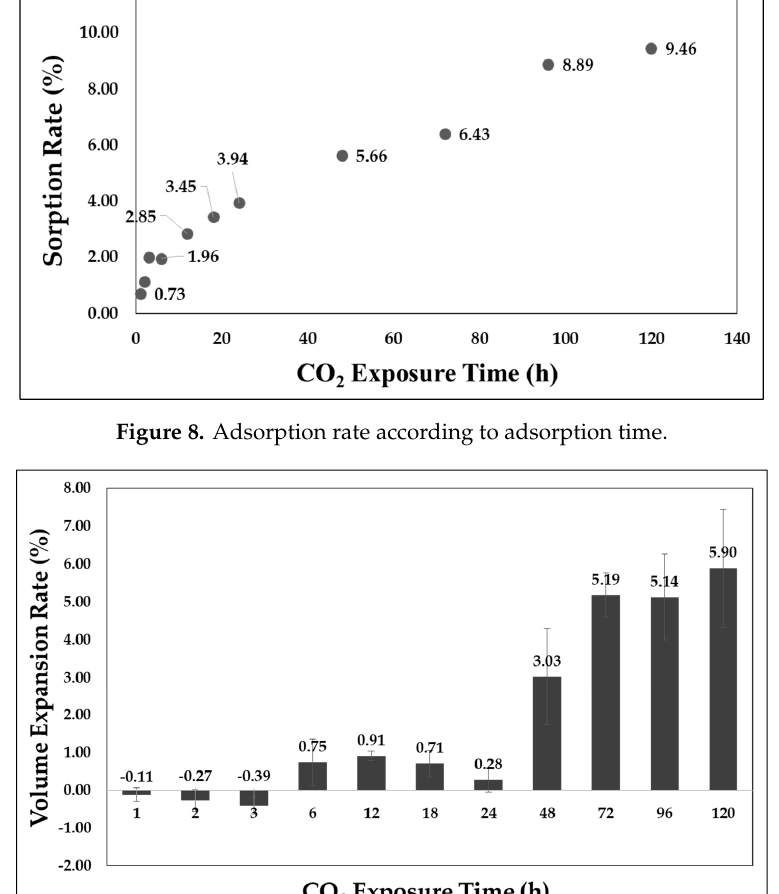
Figure 9. Volume expansion ratio according to adsorption time.